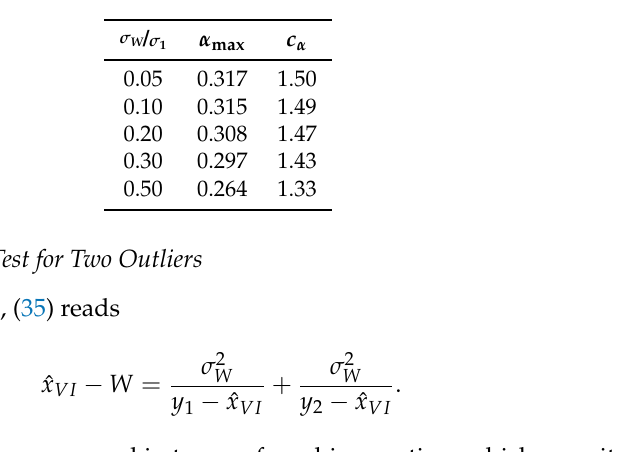
Table 1. Maximum selectable type 1 error probability α max and critical value c α for T VI in (54) for various ratios of σ W / σ 1 and α =